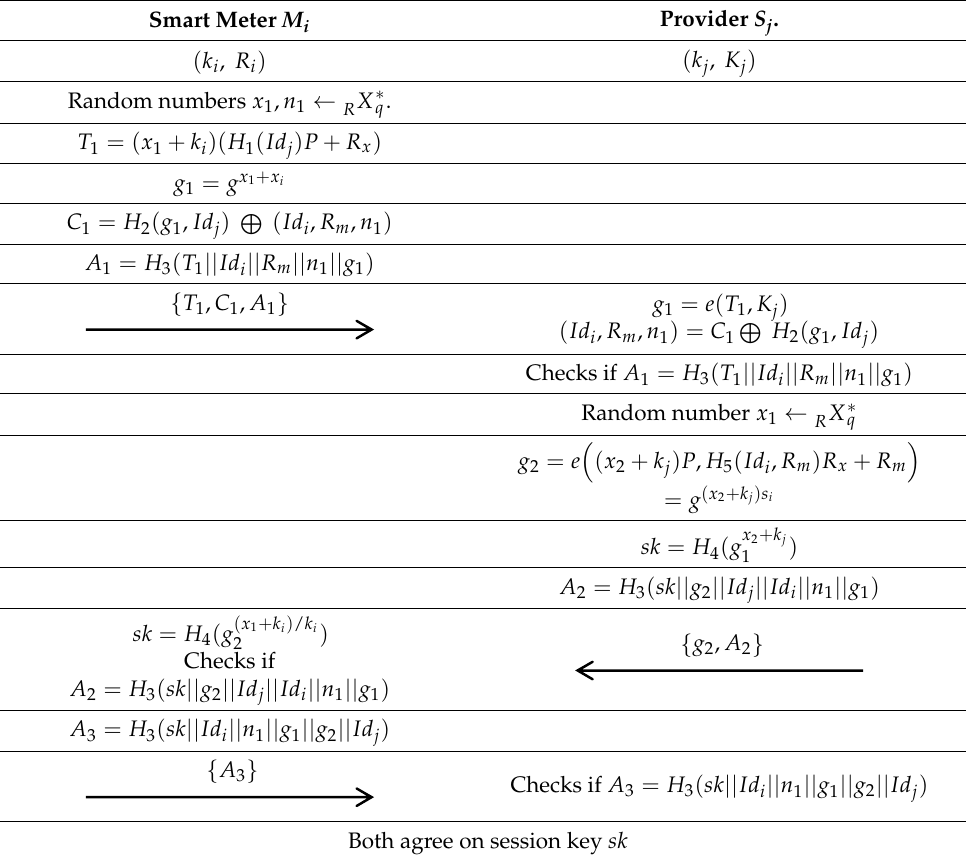
Table 8. Request and authentication phase of the proposed